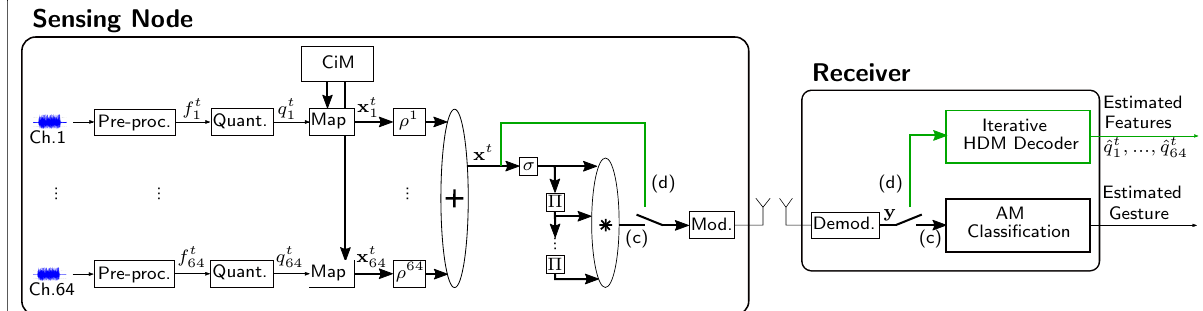
Fig. 11 EMG use-case with hybrid modes: a classification mode (c), and a data transmission mode (d). Both modes use the same spatial encoder consisting of pre-processing, quantization to 128 levels, mapping to HD vectors with continuous item memory (CiM), and superposition. In classification mode (c), n subsequent vectors are converted to bipolar vectors with σ( . ) , encoded to an n-gram, transmitted over a wireless channel, and classified with the AM search. In data transmission mode (d), the spatial vector is directly transmitted over the channel and decomposed using the iterative HDM